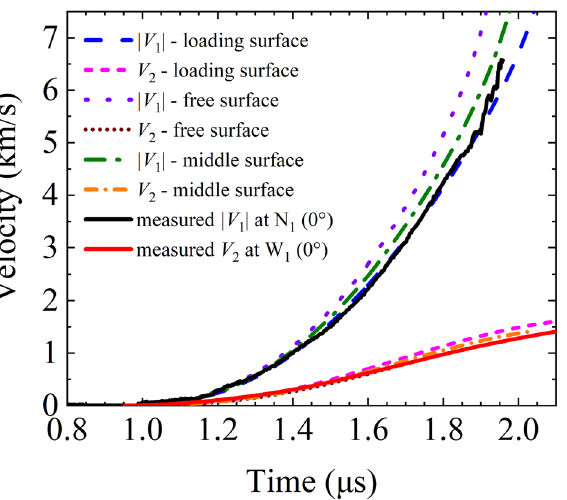
Figure 10. Calculated velocity V n for the thin-shell model with different initial radial positions as the characteristic